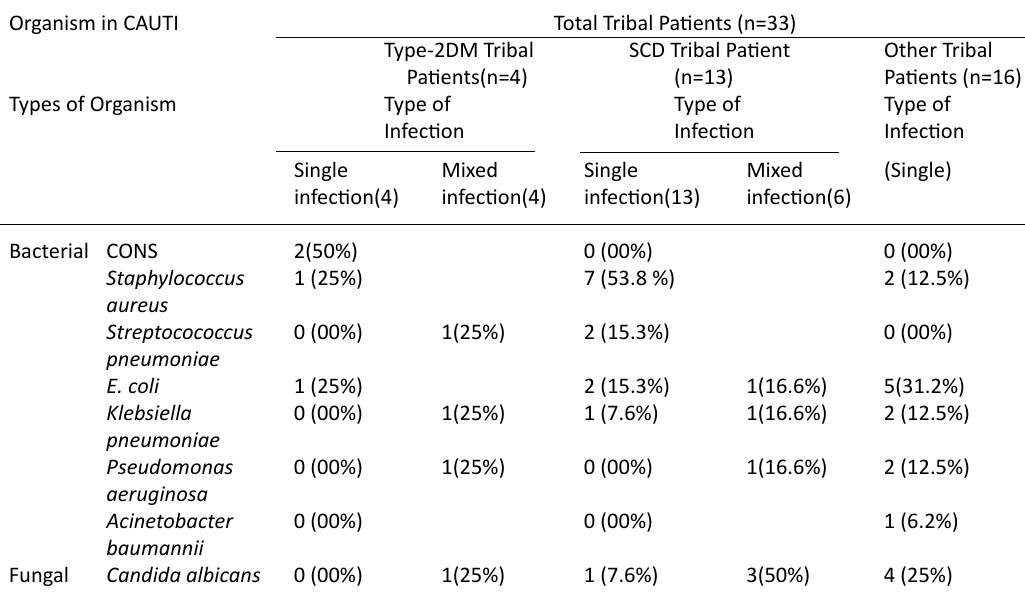
Table 6. Distribution of Pathogens according to associated co morbidities as risk factor in Tribal patient Organism in CAUTI